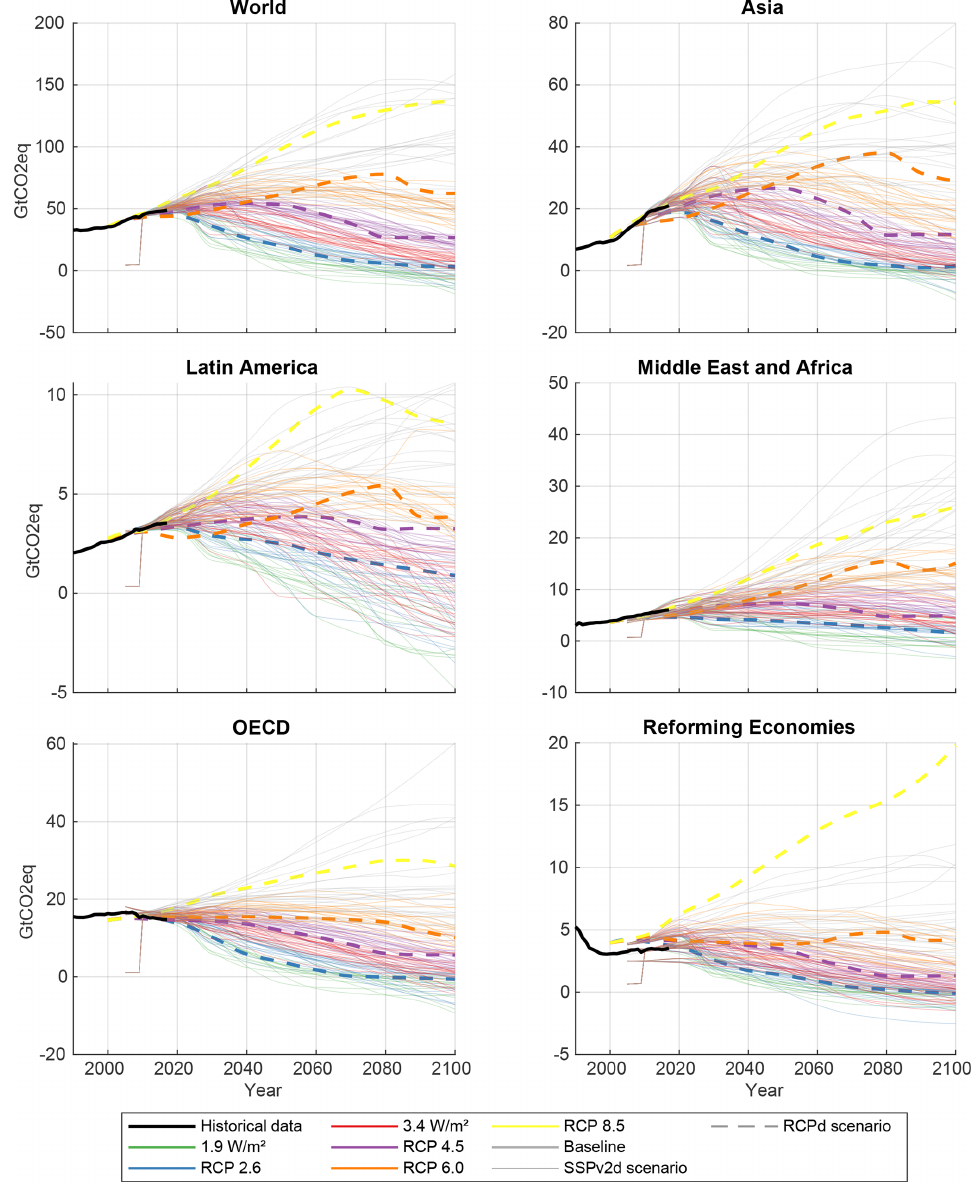
Figure 3. RCP and SSPv2 scenarios for total Kyoto GHG emissions (AR4 GWPs; global warming potentials) excluding LULUCF (land use, land use change, and forestry). Scenarios are not harmonized to historical data. Historical data shown are from PRIMAP-hist with bunker fuel CO 2 emissions added from CDIAC (Carbon Dioxide Information Analysis Center) data (Boden et al., 2017; Andres et al., 1999; Marland and Rotty,